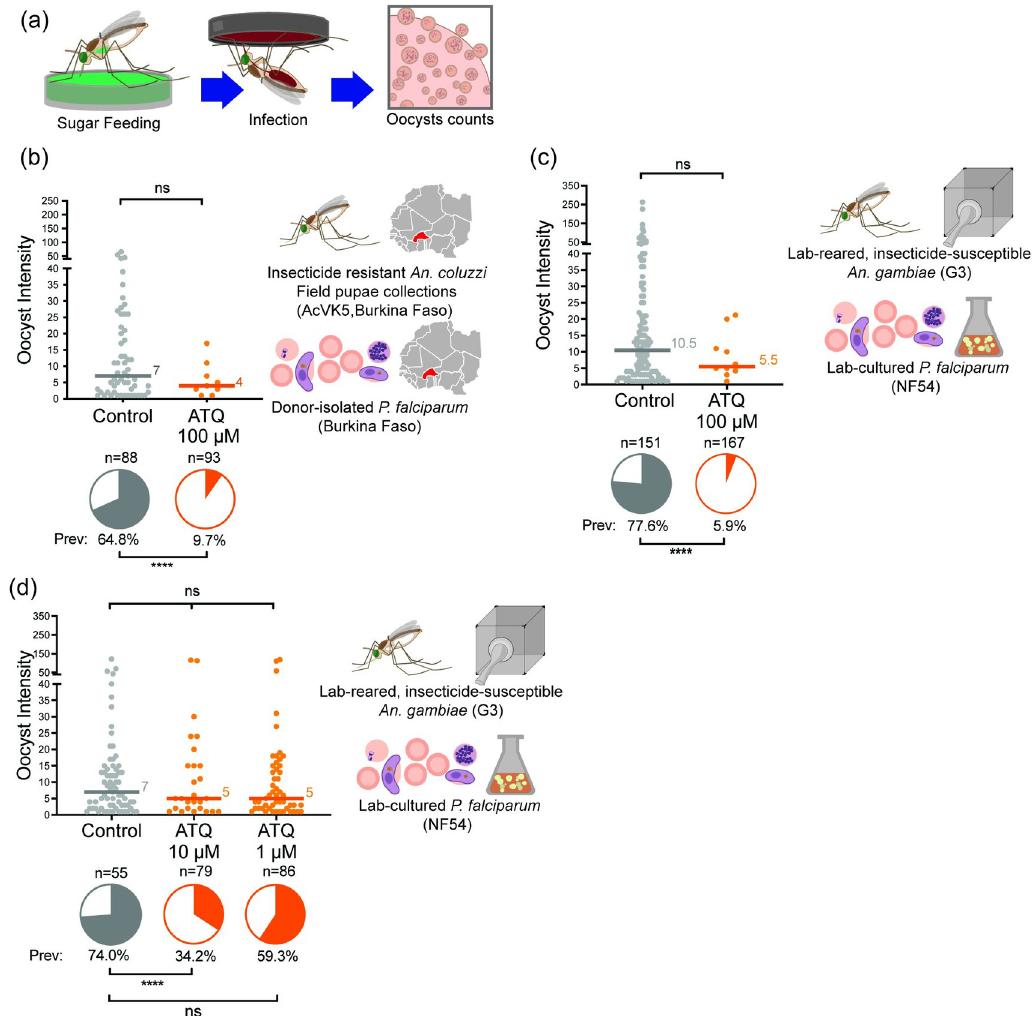
Fig 4. Ingestion of an ATQ-glucose solution prior to P . falciparum infection significantly reduces transmission. (a) Experimental scheme. (b) AcVK5, collected as pupae from field sites in Bama, Burkina Faso, mosquitoes were significantly less likely to become infected with P . falciparum (human gametocyte donor sample) after ingestion of 100 μ M ATQ/10% w/v glucose (access to treated sugar 24 h prior to infection). The proportion of AcVK5 mosquitoes infected with P . falciparum oocysts at 7 d pIBM was reduced from 64.8% in the control group, to 9.7% in mosquitoes given access to ATQ/sugar solution (85.0% reduction, GLM (Binomial;Logit), n = 181, df = 1, Χ 2 = 59.242, p < 0.0001). While median intensity of infection in mosquitoes harboring � 1 oocyst was reduced in ATQ-treated mosquitoes, this reduction was not significant. (c) Infection with culture adapted NF54 P . falciparum in insecticide susceptible G3 An . gambiae produced remarkably similar results. Ingestion of 100 μ M ATQ/0.5% DMSO/10% w/v glucose (access to treated sugar 24 h prior to infection) significantly reduced the prevalence of infection at 7 d pIBM (92.4% reduction Chi 2 , n = 318, df = 1, Χ 2 = 162.467, p < 0.0001) but had no detectable effect on the median intensity of infection (Mann-Whitney, n = 128, df = 1, U = 480.5, p = 0.3364). (d) Significant, dose-dependent inhibition of oocyst prevalence was observed with a 10-fold reduction in ATQ concentration (10 μ M: Chi 2 , n = 134, df = 1, Χ 2 = 19.275, p < 0.0001). A non- significant reduction in prevalence was also observed at 1 μ M (Chi 2 , n = 141, df = 1, Χ 2 = 2.642, p = 0.1041). Median lines and values are indicated, “n” indicates the number of independent samples. To isolate Oocyst Prevalence and Oocyst Intensity, midgut samples with zero oocysts have been excluded from intensity analysis. Statistical significance is indicated where relevant as follows: ns = not significant, � = p < 0.05, �� = p < 0.01, ��� = p < 0.001, ���� = p <